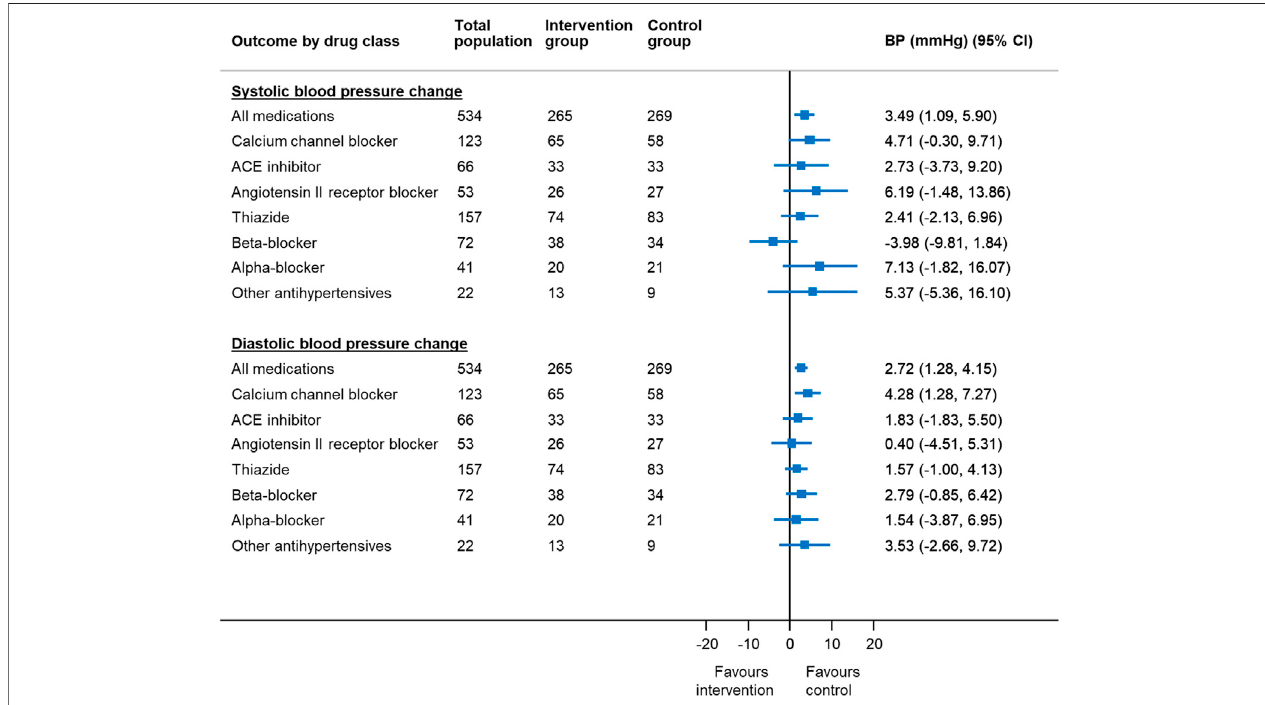
FIGURE3| Meanchangeinblood pressureinpatientsreducingantihypertensivemedicationcompared tousualcare,bydrugclasschosenforwithdrawal* *Since thetreatingphysician ’ schoiceofmedicationtowithdrawwasmadepriortoconsentandrandomization,datawereavailableforallrandomizedparticipants,eventhough only half went on to have the medication withdrawn in the trial. BP (cid:2) blood pressure; CI (cid:2) con fi dence interval Generalized linear mixed model with binomial error and log link, with factors predictive of physician choice of drug to withdraw (see Table 2 ) and baseline systolic blood pressure, gender, cognitive function (MoCA Score), EQ-5D-5L Index and Searle Frailty Index as fi xed effects and primary care site as a random effect.